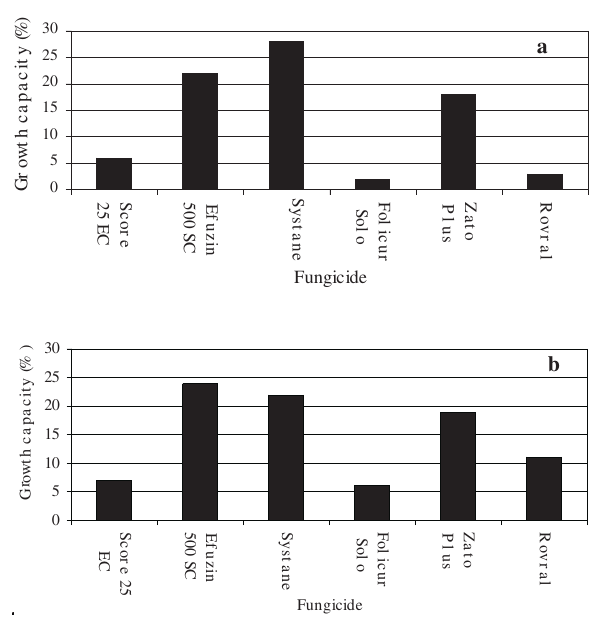
Figure 4. Percent growth capacity of two Monilinia laxa isolates (a and b) for 6 fungicides (approved in integrated production) admended on PDA plates at 0.5 x dosage recommended by the